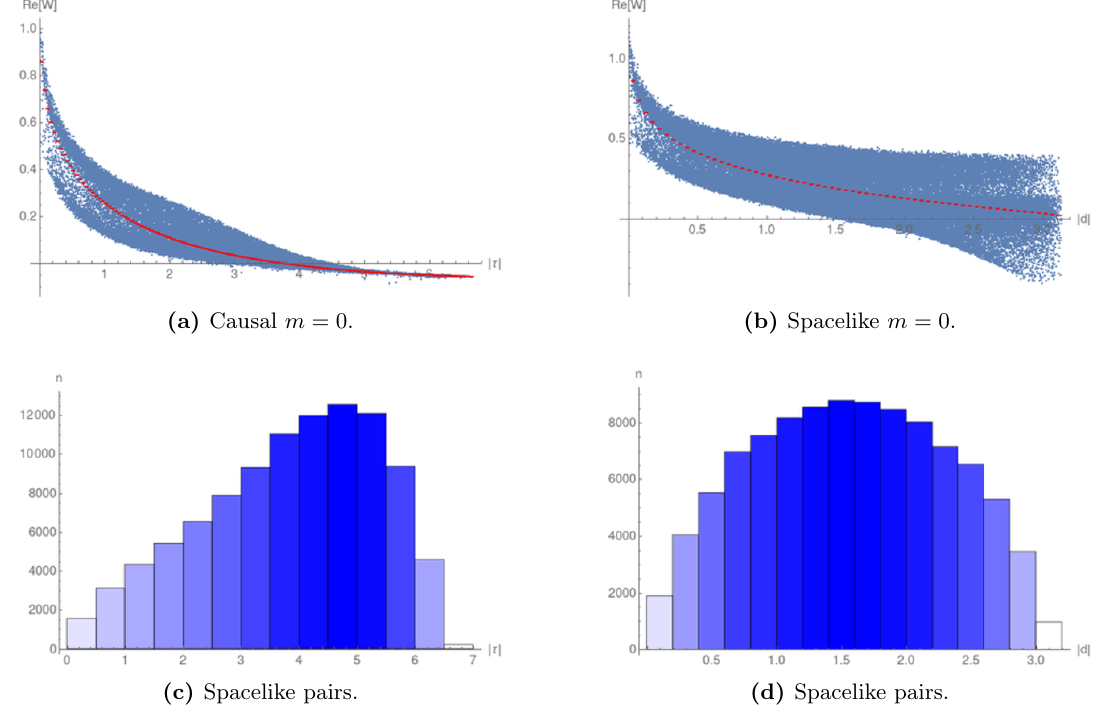
Figure 13. N = 36000 ; T = 1 : 5 ; (cid:26) = 203 : 15, in 2d de Sitter. (a)-(b) represent Re[ W distance for a sample of 100000 randomly selected pairs. The red curve represents the mean values with the SEM. (c)-(d) are plots of the distribution of pairs.